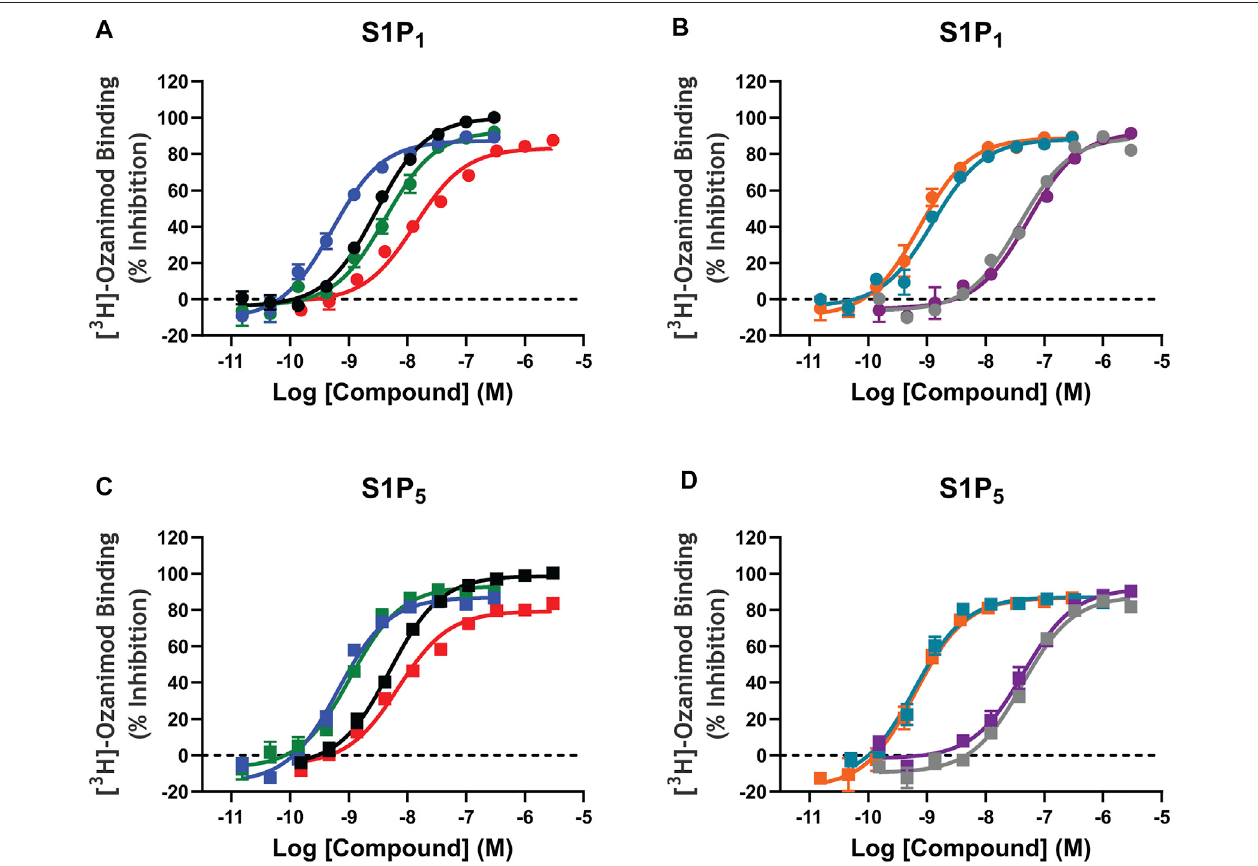
FIGURE 2 | [ 3 H]-Ozanimod competition radioligand binding concentration response curves. A – D: [ 3 H]-ozanimod was competitively displaced with increasing concertation of ozanimod (black curves), fi ngolimod-p (blue curves), siponimod (green curves), S1P (red curves), etrasimod (grey curves), ponesimod (purple curves), KRP-203-p(tealcurves),oramiselimod-p(orangecurves)usingChinesehamsterovarycellmembranesstablyexpressingrecombinanthumanS1P 1 (circles,AandB)or human S1P 5 (squares, C and D). Each concentration response curve is the mean ± standard error of the mean of 3 – 5 replicate experiments run in duplicate wells. S1P, sphingosine 1-phosphate; S1P 1 , sphingosine 1-phosphate receptor subtype 1; S1P 5 , sphingosine 1-phosphate receptor subtype